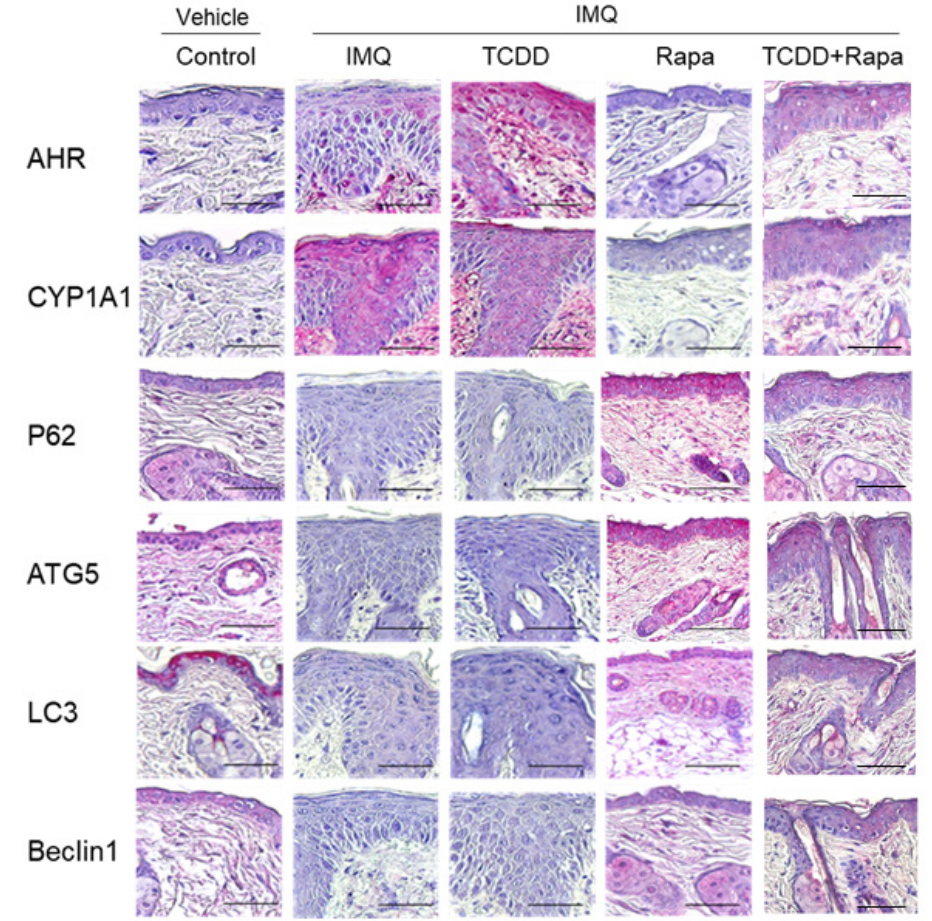
Figure 6. Immunohistochemical analysis of AHR, CYP1A1, and autophagy-related factors in skin tissue of mice from 5 different treatment regimens with vehicle control, IMQ, IMQ + TCDD, and IMQ + Rapa, or IMQ + TCDD + Rapa. Immuno- histochemical staining with the indicated antibodies is shown from 1 representative mouse from each group ( n = 5). Scale bars represent 50 μ m. IMQ: imiquimod, Rapa: